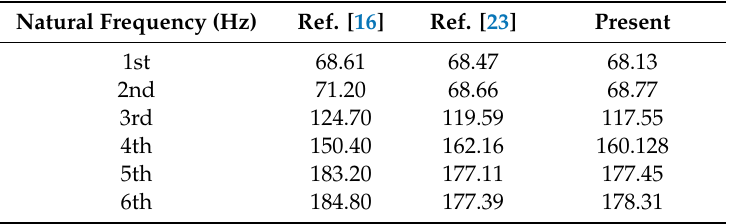
Figure 4. Displacement-time responses of the center of the square model subjected to air blast. The last case is the polyester model with stiffeners placed at the center. Two opposite edges are free, and the others are clamped. The structure and stiffeners are made with the isotropic materials as follows: E = 7.0 GPa, G = 2.6 GPa, ρ = 1504.2 kg / m 3 and ν = 0.345. The natural frequencies of the model are well-matched with the previous data [16,23], as shown in Table 2. Table 2. Natural frequencies of stiffened models.